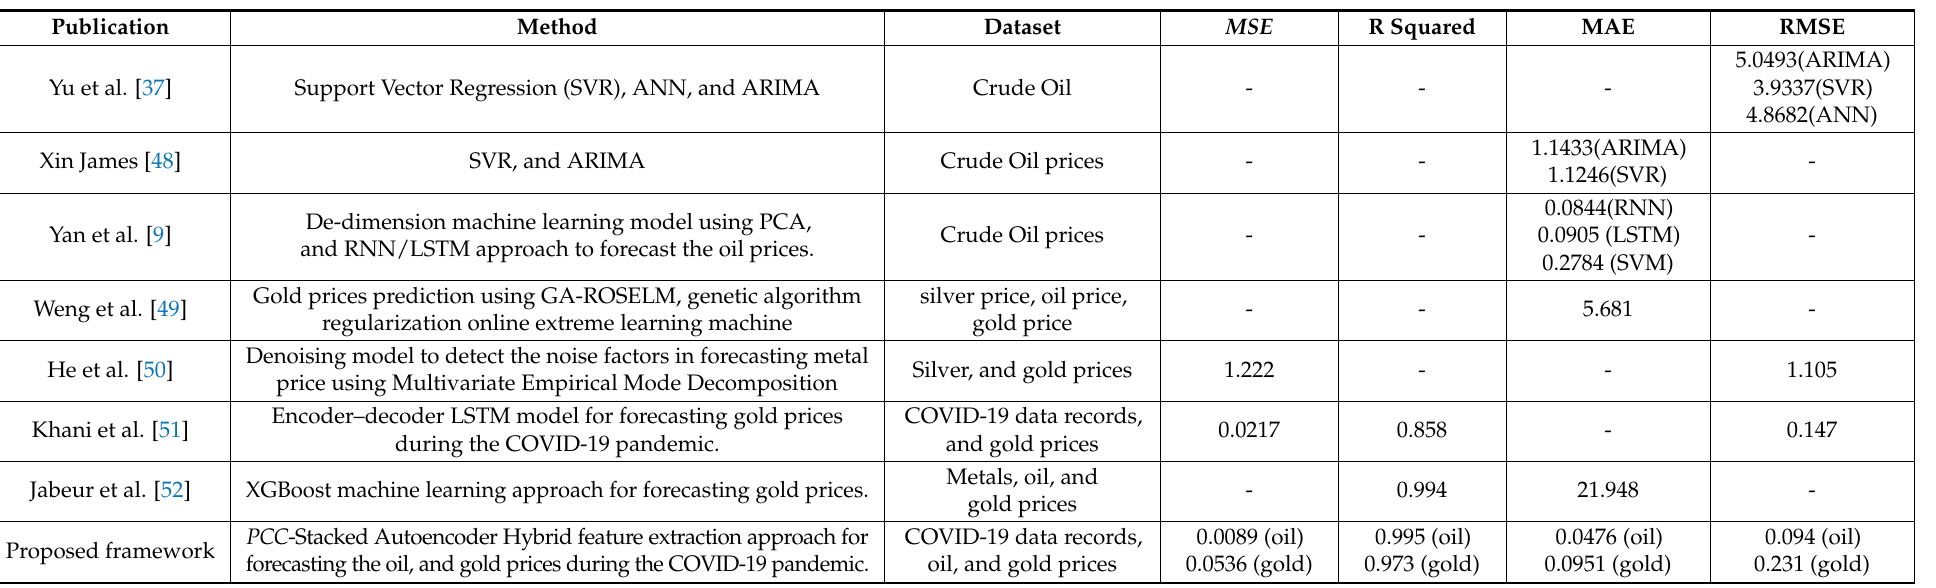
Table 5. Comparing the results of the proposed framework for forecasting the oil, and gold prices with state-of the-art forecasting models.